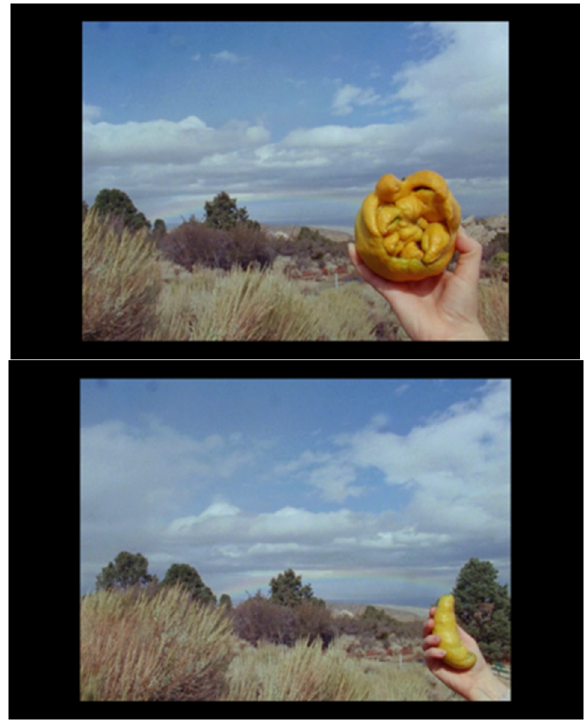
Figure 7. Words, Planets (2018).